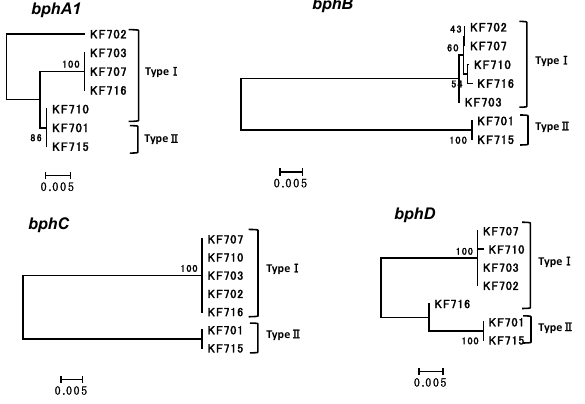
Figure 3. Phylogenetic tree of bphA1 , bphB , bphC , and bphD of KF strains in groups I and II (types I and II bph genes). The multiple alignment outputs were used to generate neighbor-joining phylogenetic trees using MEGA 6.0 [33]. The bar indicates expected nucleotide substitutions per site.